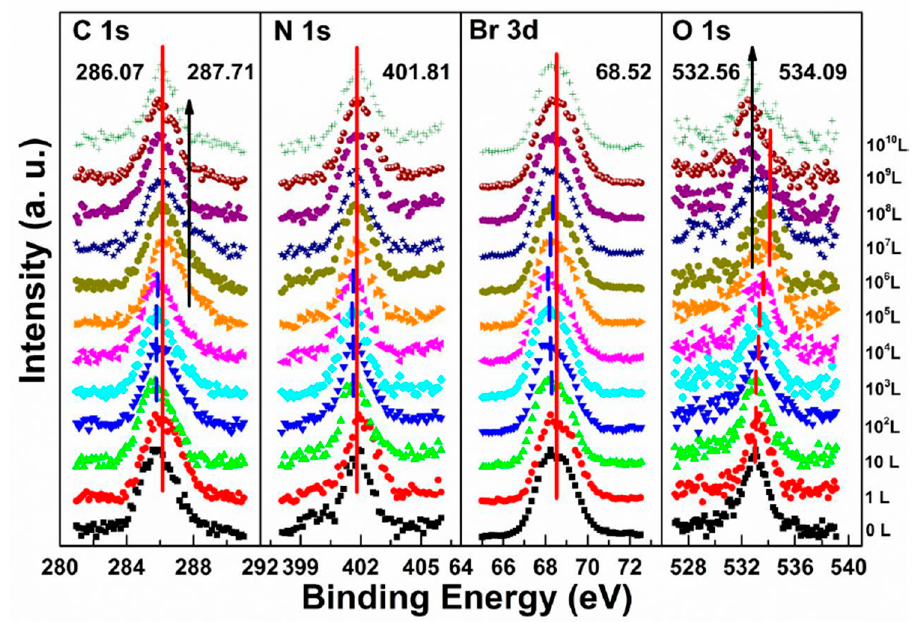
Figure 9. Evolutions of C 1s, N 1s, Br 3d, and O 1s XPS spectra of cleaved MAPbBr 3 single crystal under O 2 exposures. From Ref. [38] with permission.